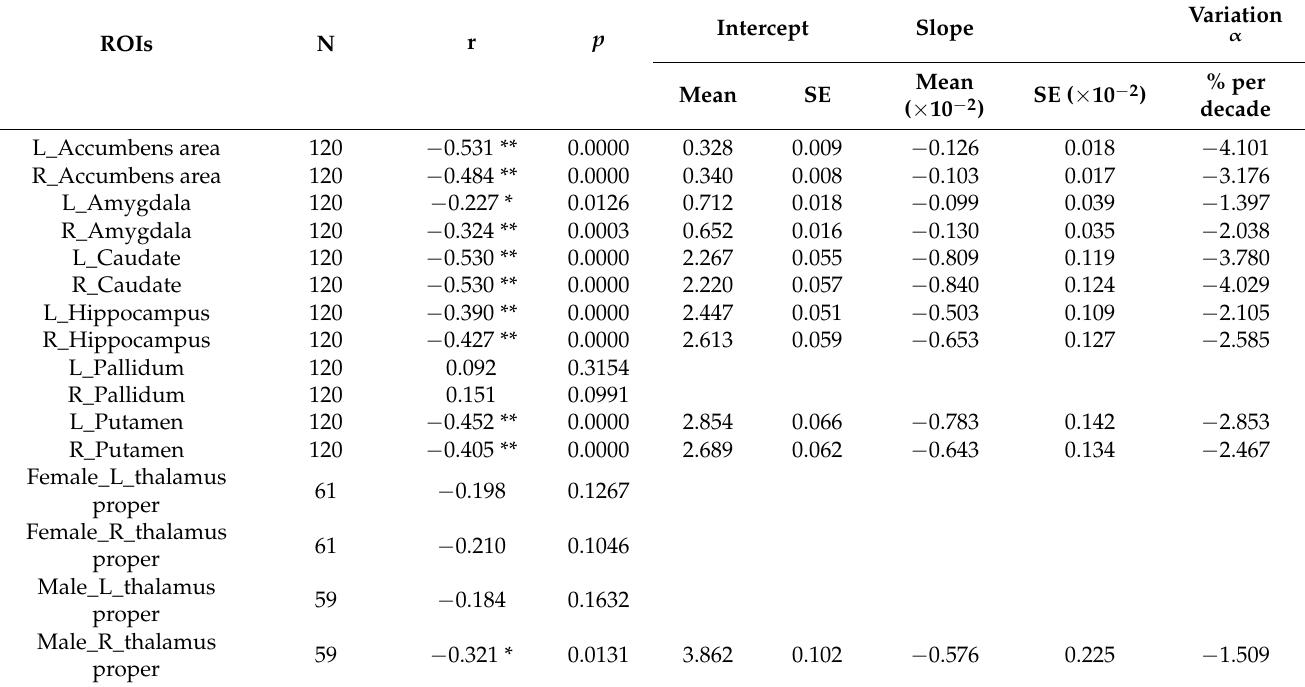
Table 2. Results of linear regression of relative SGMV values to age in healthy